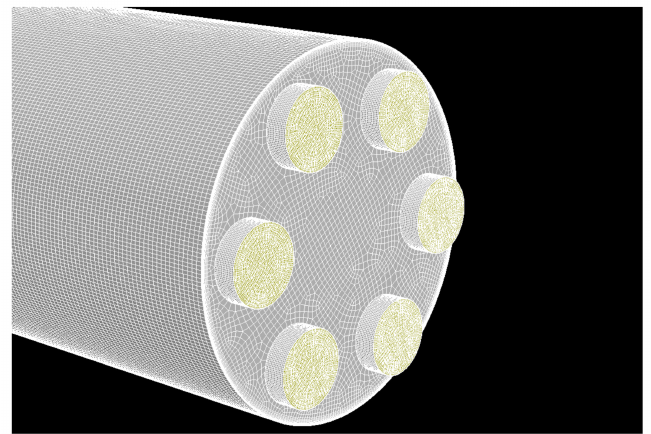
Figure 20. Close-up of the computational mesh (10 million elements in total) in the vicinity of orifice holes.